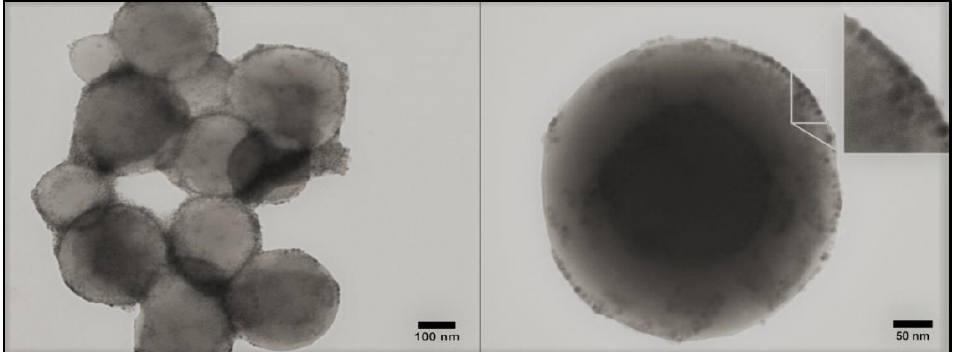
Figure 4. TEM images of magneto-liposomes (MLP50) ( left ); unstained TEM image of a single magneto-liposome (MLP50) ( right ). The inset magnifies a membrane portion highlighting the incorporation of SPIONs in the lipid bilayer.